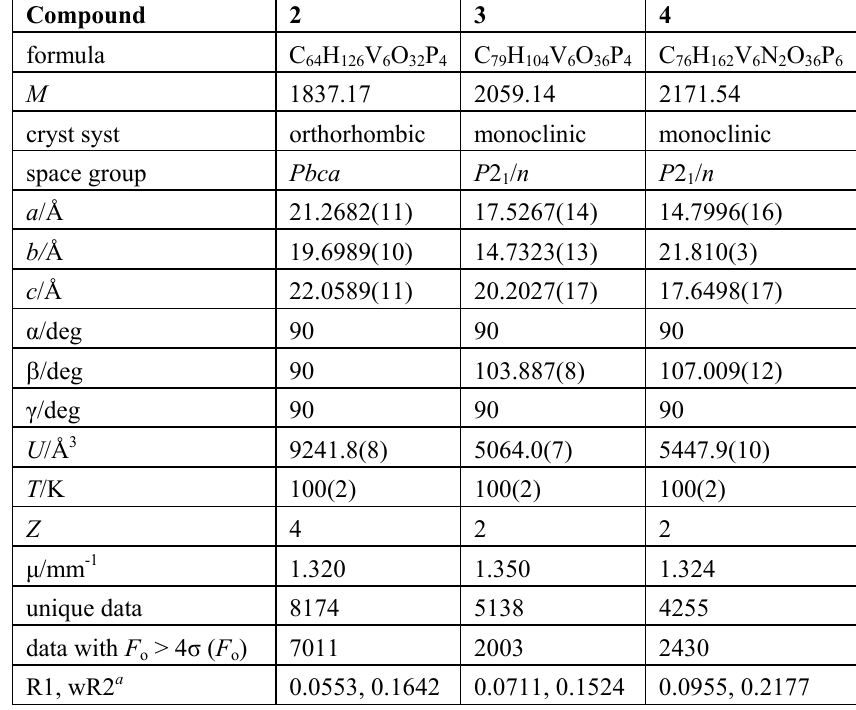
Table 1. Crystal data for 2–4.